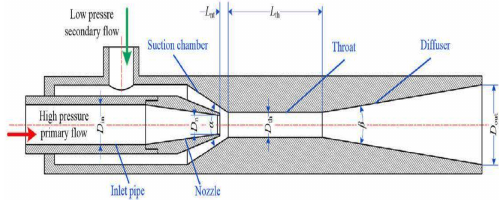
Figure 8. Schematic drawing of a JPCR